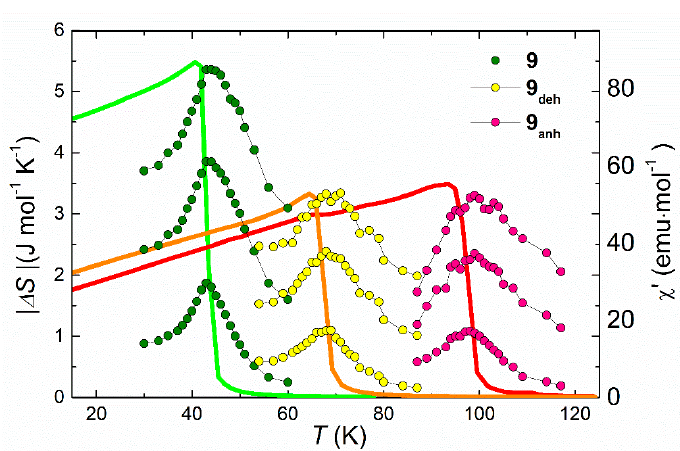
Figure 24. The comparison of temperature dependences of the magnetic entropy change measured for µ 0 ∆ H = 1, 3, and 5 T (symbols) and real component of AC susceptibility for 9 , 9 deh , and 9 anh (lines).